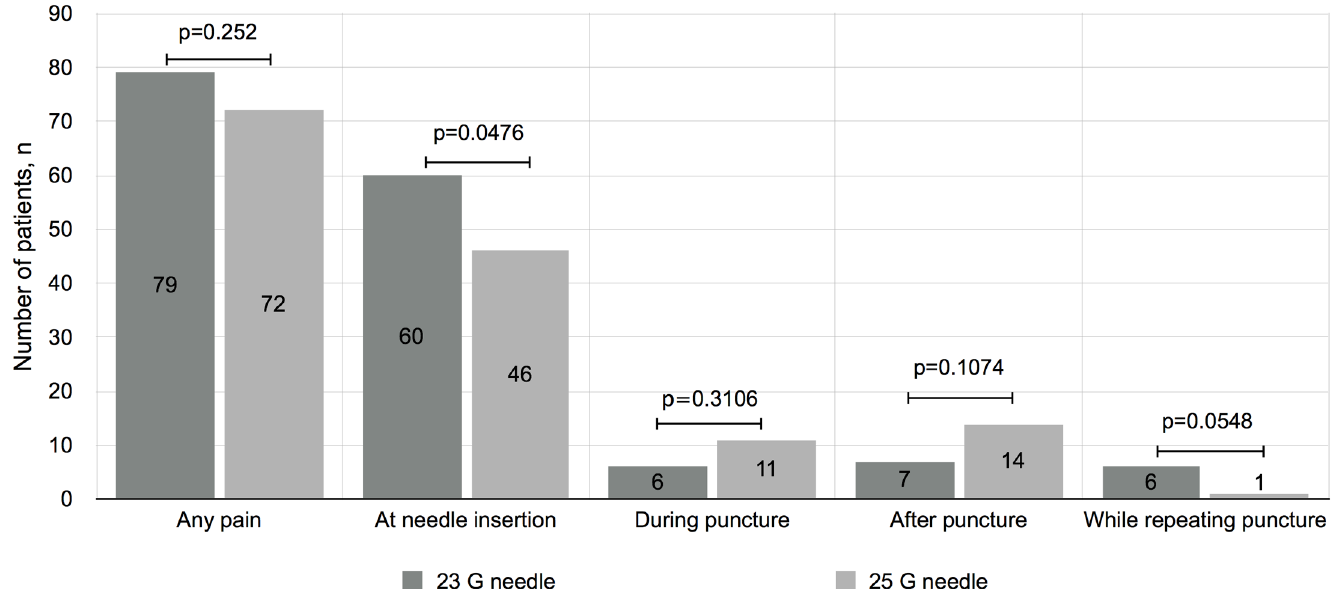
Fig 2. Most painful moment during arterial puncture. Distribution of the most painful time during the arterial punctures for each needle size (p =